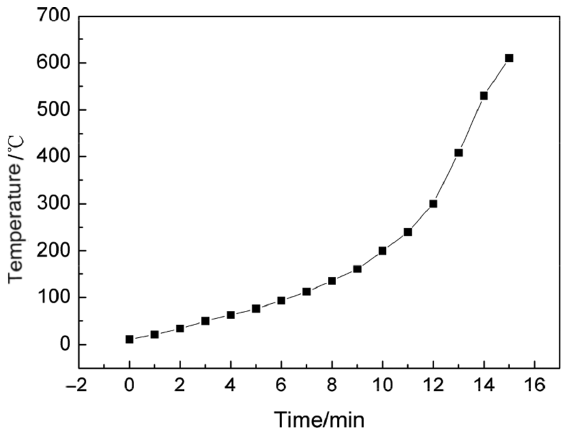
Figure 4: The heating curve of CuCl residue under microwave irradiation.